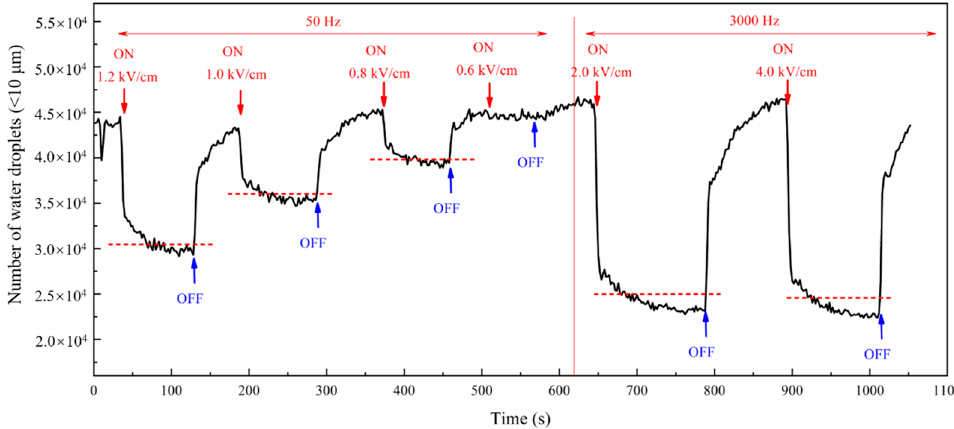
Figure 18. Variations of water droplets number within 10 μ m (water content 20%).